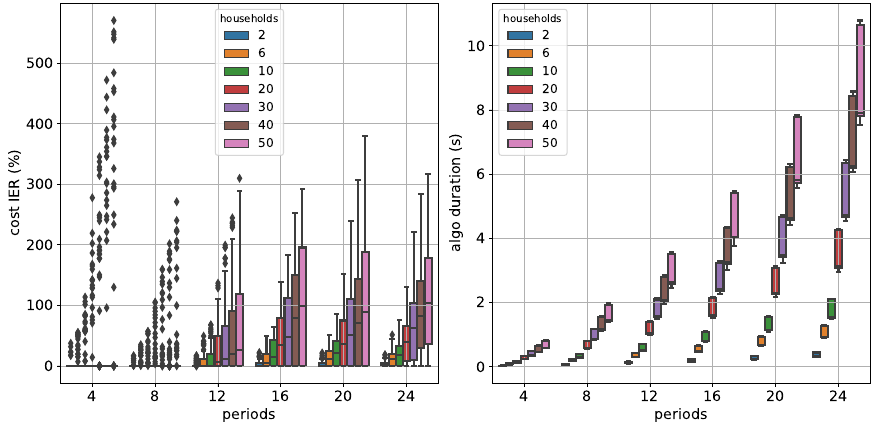
Figure 4. Spread of the quality measures cost IER and algo duration for the algorithm OA by RHS Summation with PC using boxplots ordered by households from left 2 to right 50.